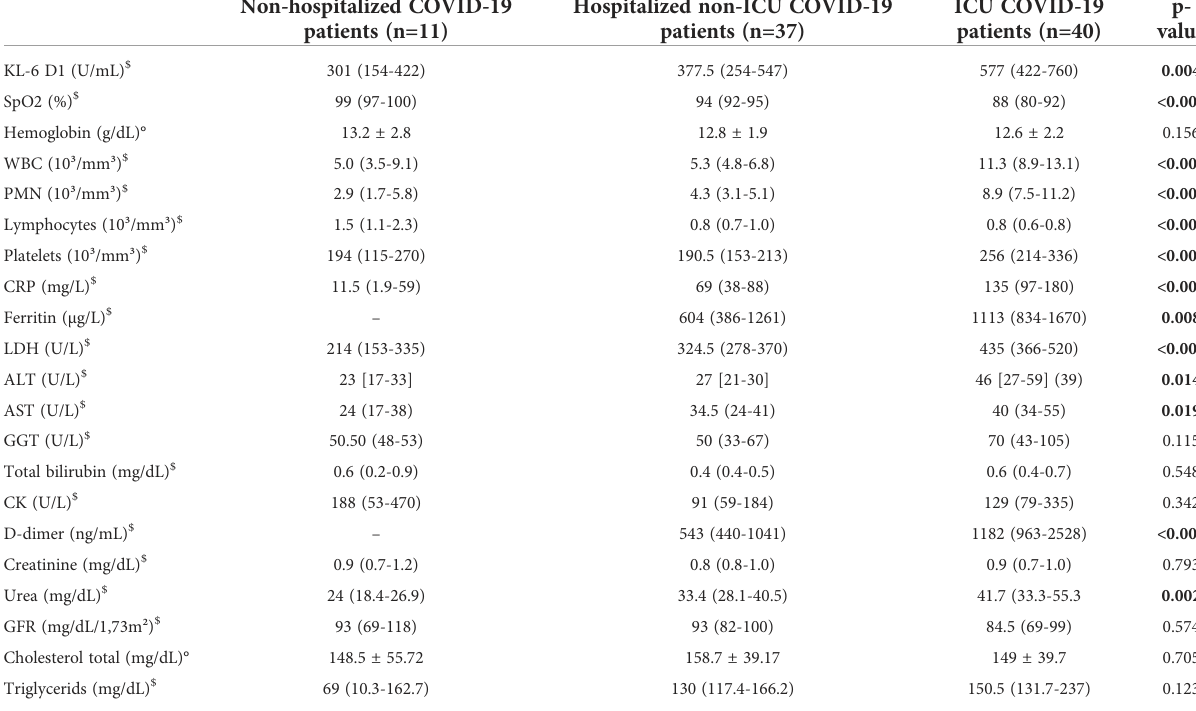
TABLE 2 Main biological parameters at